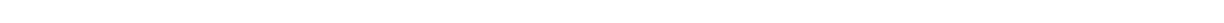
Fig. 8 Mutant SRSF2 -associated Cassette Exons in EZH2 . a , b Forest plots show relative frequencies of CCNG and GGNG motifs within the differentially spliced exons in the SRSF2 -mutated samples. Two panels show the exons that are more frequently included ( n = 380) ( a ) and skipped ( n = 645) ( b ) in the SRSF2 -mutated samples, respectively. Comparisons were made between the differentially spliced exons and constitutive ones ( n = 72,002). Red and blue dots indicate relative frequencies of CCNG and GGNG, respectively. Bars indicate 95% con fi dence intervals. Relative frequencies are shown for exons divided into four segments with equal lengths. c Two cassette exons in EZH2 associated with SRSF2 mutation. The left is alternative exon usage and the right is exon skipping. Gray boxes indicate constitutive exons. Red and blue boxes denote exons with increased and decreased usage in the SRSF2 -mutated samples, respectively. d PSI values of the cryptic exon between exons 9 and 10 of EZH2 . BMMNC samples with different SF mutation status are plotted separately. The middle line in each box corresponds to the median; the lower and upper boundaries of the box indicate fi rst and third quartiles, respectively. The whiskers represent the 1.5-fold interquartile range or the maximum/minimum data point within the range. *** indicates Bonferroni adjusted P value < 0.001; **, adjusted P value < 0.01; *, adjusted P value < 0.05. e PSI values of exon 11 of EZH2 . SRSF2 -mutated samples and those without SF mutations are plotted separately for BMMNCs and CD34 + cells. The number of samples in each group is shown in Fig. 1c. f mRNA levels of EZH2 isoforms compared between the SRSF2 -mutated samples and those without SRSF2 and EZH2 alterations. One sample with both SRSF2 and EZH2 mutations were removed from this analysis. Normal transcripts are those from an EZH2 isoform without SRSF2 -associated alterations in exon usage. Truncated transcripts are those from EZH2 isoforms with at least one SRSF2 -associated altered exon usage. Levels of normal transcripts were compared using the Mann – Whitney U test. W - values were 340 in CD34 + cells and 630 in